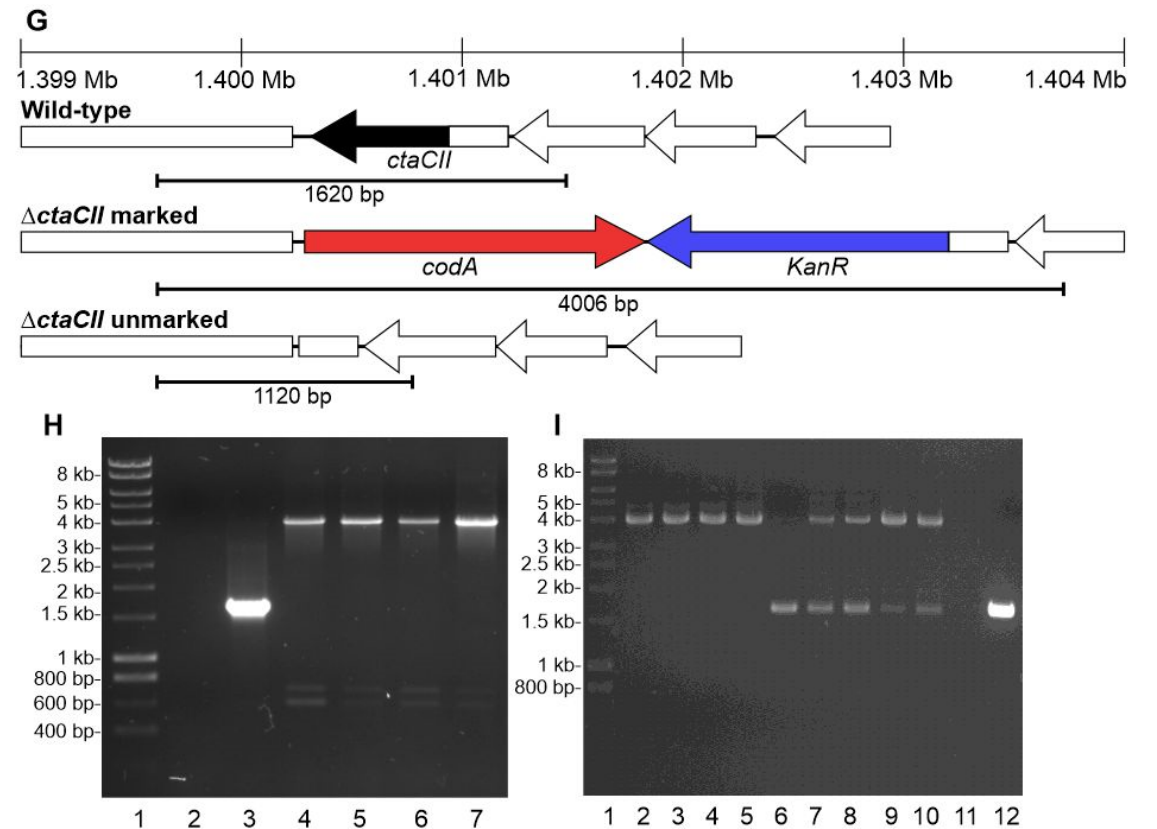
Figure 5. Generation of marked knockouts and attempted generation of unmarked knockouts in PCC 11901. DNA ladders are shown in lane 1 in each panel. ( A ) Schematic representations of locus location in the PCC 11901 genome (top) and profiles expected in wild-type and the ∆ desB marked and unmarked knockouts. ( B ) Amplification of genomic DNA in WT (Lane 3; Expected band size: 1477 bp) and ∆ desB marked mutants (Lanes 4–7) using DesBfor and DesBrev primers. Positive control is shown in lane 2. ( C ) Amplification of genomic DNA in the desB marked mutant (Lanes 5) and putative desB unmarked mutants (Lanes 2–4, 6) using DesBfor and DesBrev primers. ( D ) Schematic representations of locus location in the PCC 11901 genome (top) and profiles expected in wild-type and the ∆ ctaDI marked and unmarked knockouts. ( E ) Amplification of genomic DNA in WT (Lane 2) and ∆ ctaDI marked mutants (Lanes 4–9) using COXfor and COXrev primers. Negative control (no gDNA) is shown in lane 3. ( F ) Amplification of genomic DNA in putative ∆ ctaDI unmarked mutants (Lanes 2–11) using COXfor and COXrev primers. Negative control (no gDNA) is shown in lane 12. Amplification of wild-type is shown in lane 13. ( G ) Schematic representations of locus location in the PCC 11901 genome (top) and profiles expected in wild-type and the ∆ ctaCII marked and unmarked knockouts. ( H ) Amplification of genomic DNA in WT (Lane 3) and ∆ ctaCII marked mutants (Lanes 4–7) using ARTOfor and ARTOrev primers. Negative control (no gDNA) is shown in lane 2. ( I ) Amplification of genomic DNA in putative ∆ ctaCII unmarked mutants (Lanes 2–10) using ARTOfor and ARTOrev primers. Negative control (no gDNA) is shown in lane 11. Amplification of wild-type is shown in lane 12.